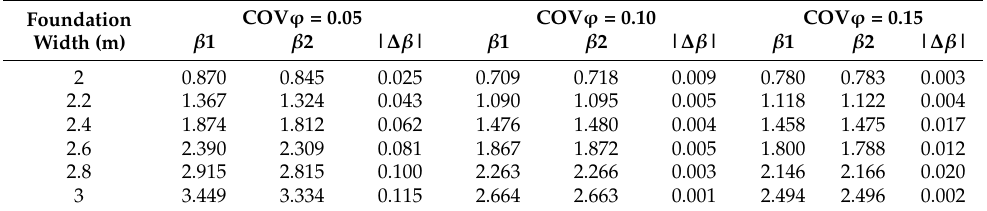
Table 8. Comparison of the results of SLS reliability analyses with different numbers of random